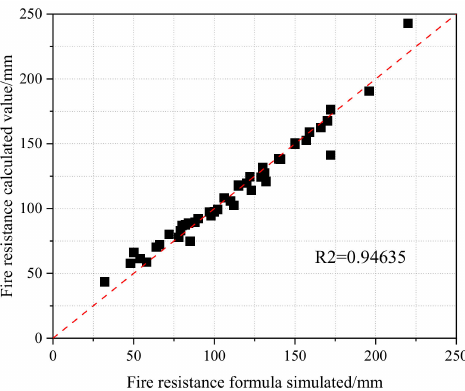
Figure 15. Numerical analysis of the fire resistance calculated value and fire resistance formula simulated value